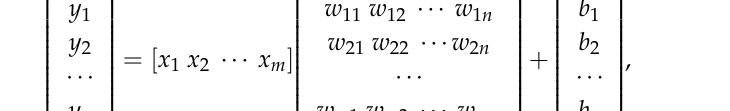
Figure 2. Structure of the designed convolutional neural network (CNN) model for normal and abnormal PCG classification. Conv1D denotes a one-dimensional convolution layer. GAP denotes the global average pooling layer.